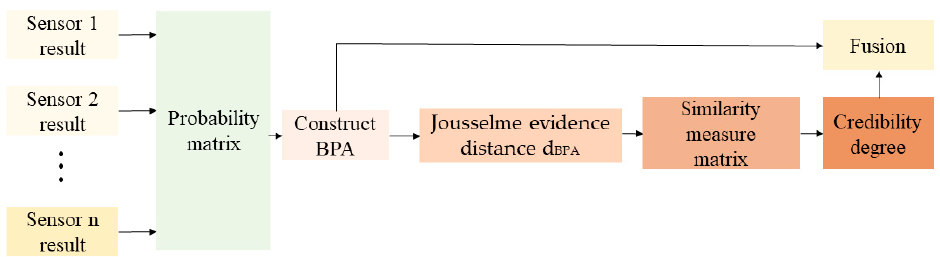
Figure 4. Intermediate visual effects of the modified average approach.